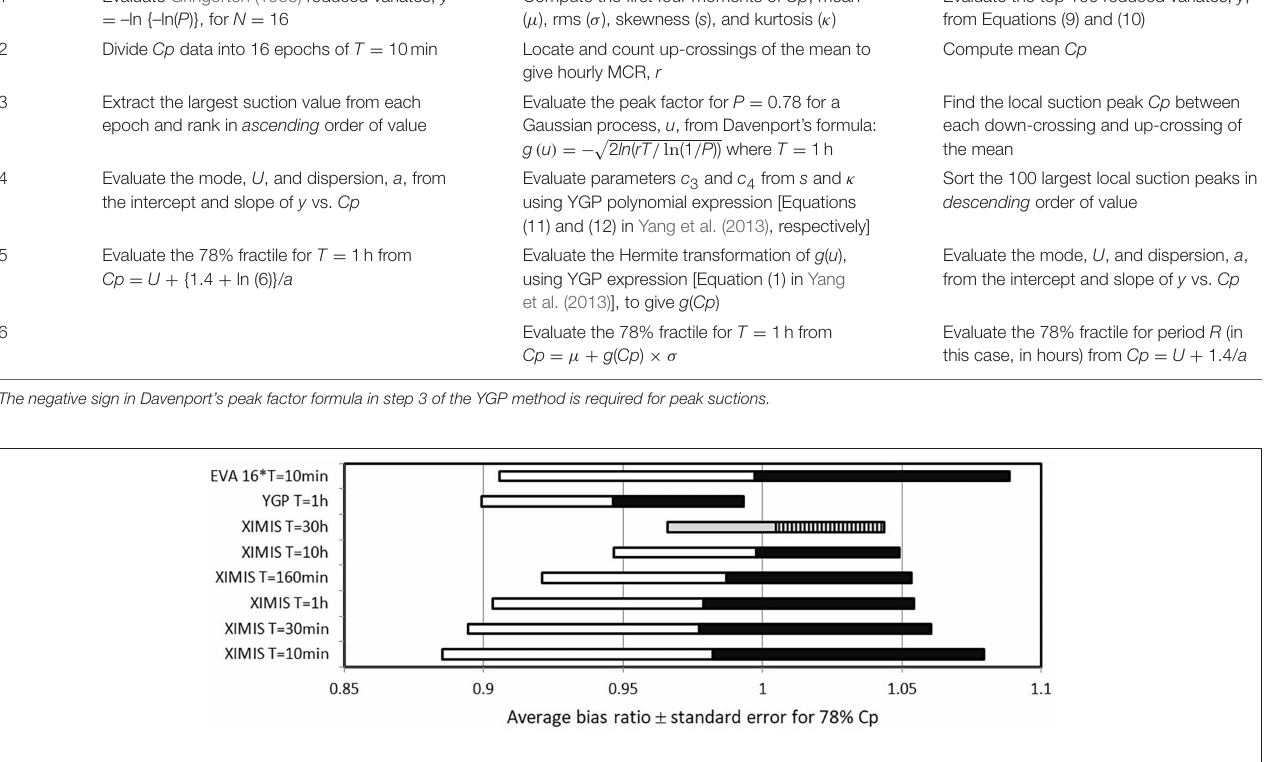
FIGURE 8 | Average of performance of